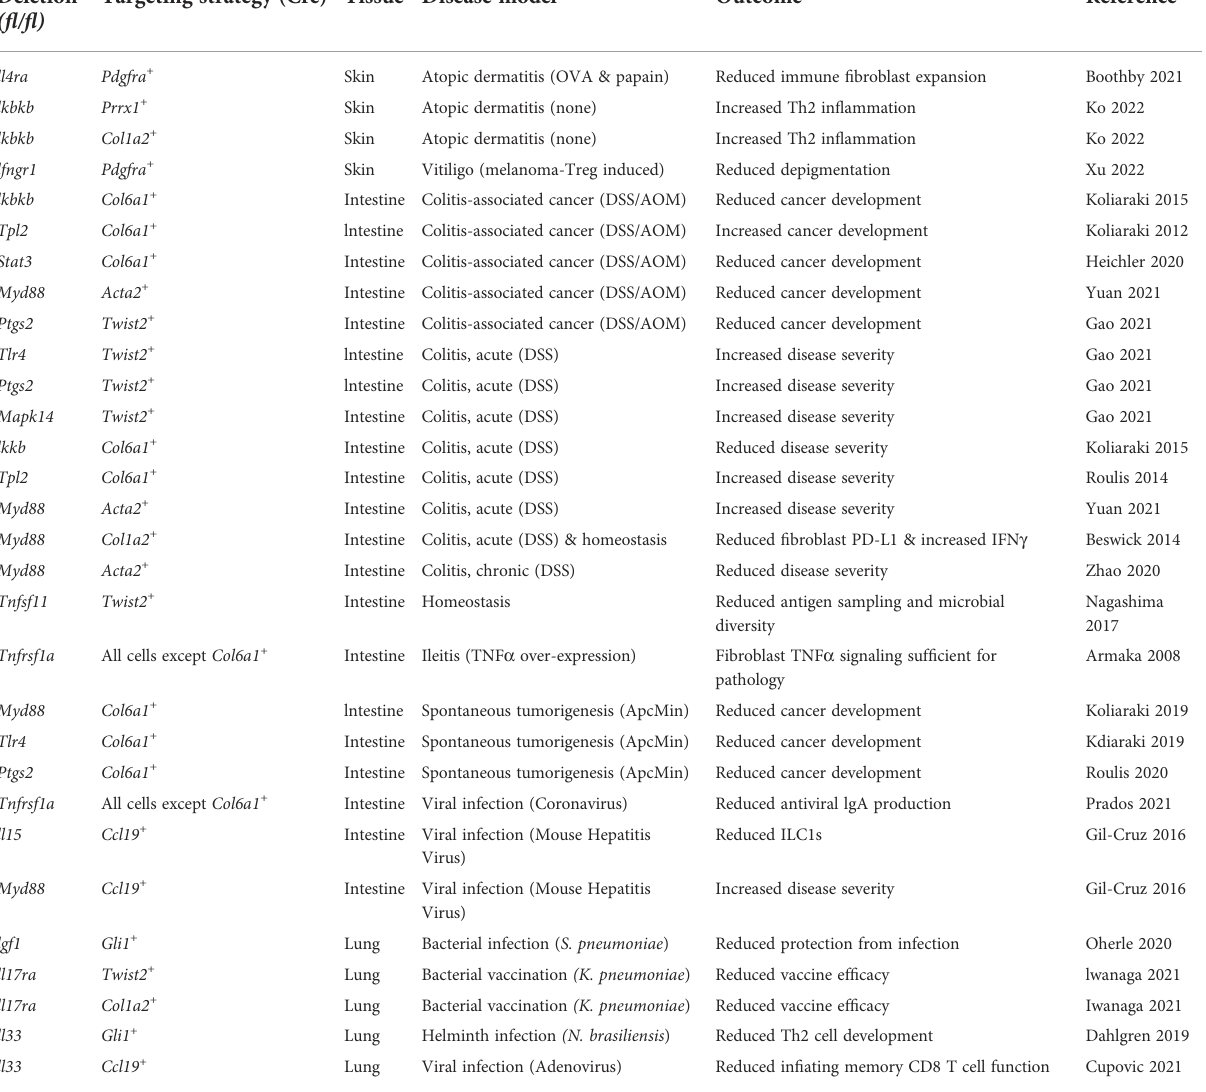
TABLE 1 Conditional knockout mice demonstrate critical role of fi broblast immune function in barrier tissue disease. Deletion Targeting strategy (Cre) Tissue Disease ( fl / fl )